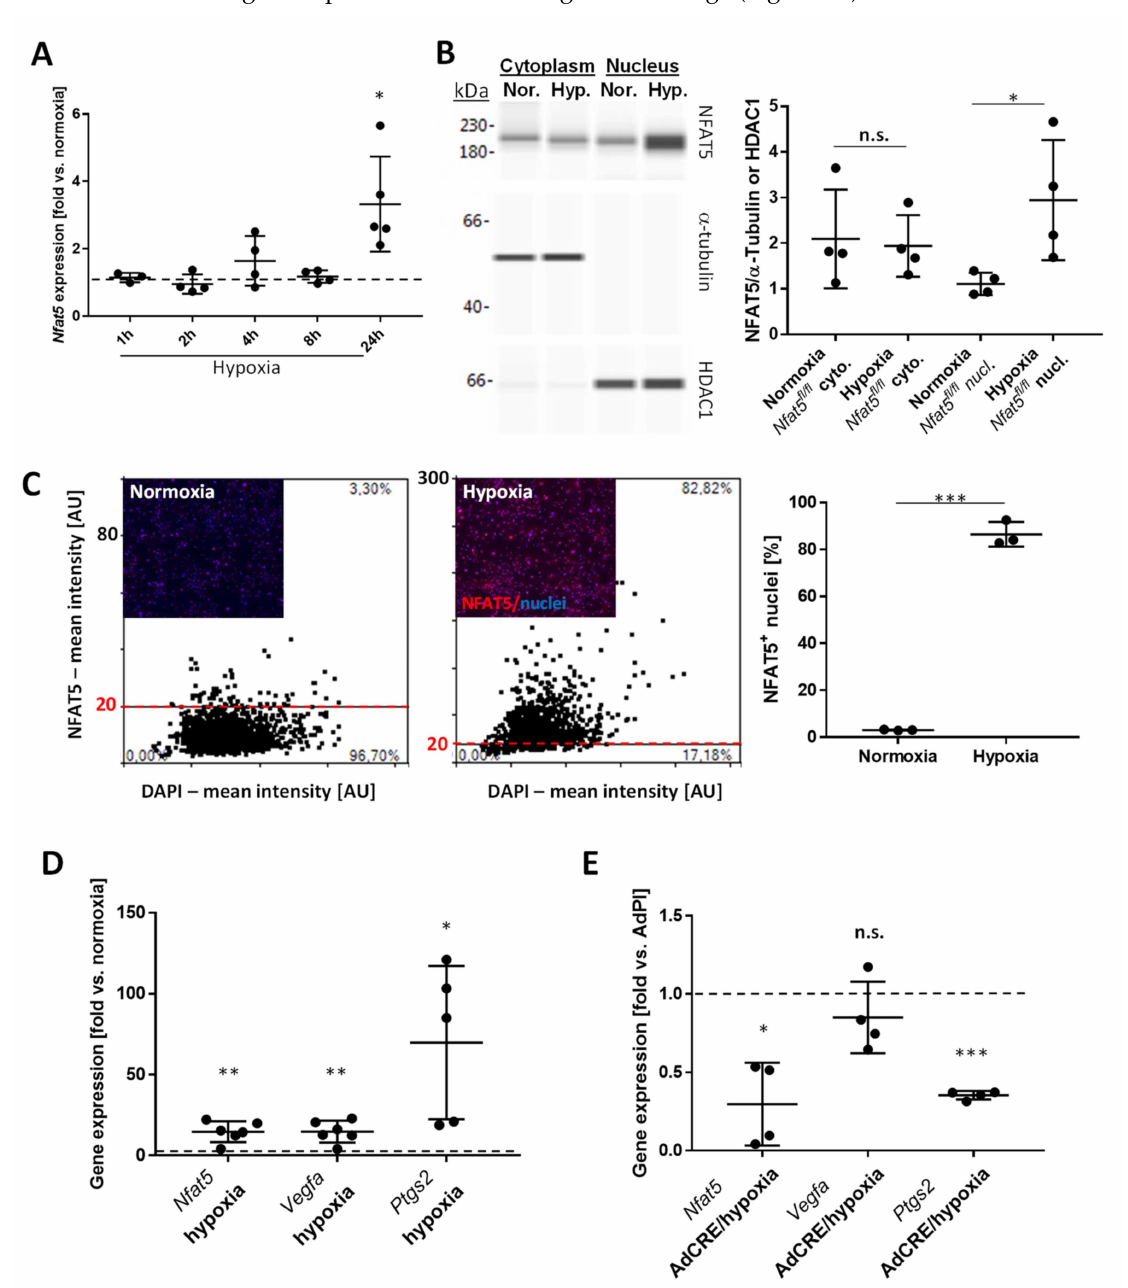
Figure 1. Nfat5 expression in mouse vascular SMCs. ( A ) Murine aortic SMCs (maoSMCs) from Nfat5 fl/fl mice were exposed to hypoxia for the indicated periods. The mRNA expression of Nfat5 was analyzed by qPCR with Actb as reference (* p < 0.05 vs. normoxia (set to 1: dashed line), one-sample t -test, n = 4–5). ( B ) Capillary electrophoresis of cytoplasmic and nuclear protein fractions of maoSMCs exposed to normoxia or hypoxia (24 h) and immunodetection of NFAT5 (not significant (n.s.) vs. cytoplasm/normoxia, * p < 0.05 vs. nucleus/normoxia, n = 4). ( C ) Immunofluorescence-based detection of NFAT5 (( C ), red fluorescence) and automated assessment (threshold level was set to 20, dashed red line) of the percentage of NFAT5-positive nuclei in maoSMCs after exposure to hypoxia for 24 h (*** p < 0.001 vs. normoxia, n = 3). ( D , E ) qPCR-based analysis of Nfat5, Vegfa, and Ptgs2 mRNA expression in maoSMCs exposed to normoxia or hypoxia for 24 h (( D ), * p < 0.05, ** p < 0.01 vs. normoxia (set to 1: dashed line), n = 5–6) as well as after genetic ablation of Nfat5 (AdCRE, AdPl treatment served as control) and exposure to hypoxia for 24 h (( E , * p < 0.05, *** p < 0.001, n.s. vs. AdPl/hypoxia (set to 1: dashed line), n =